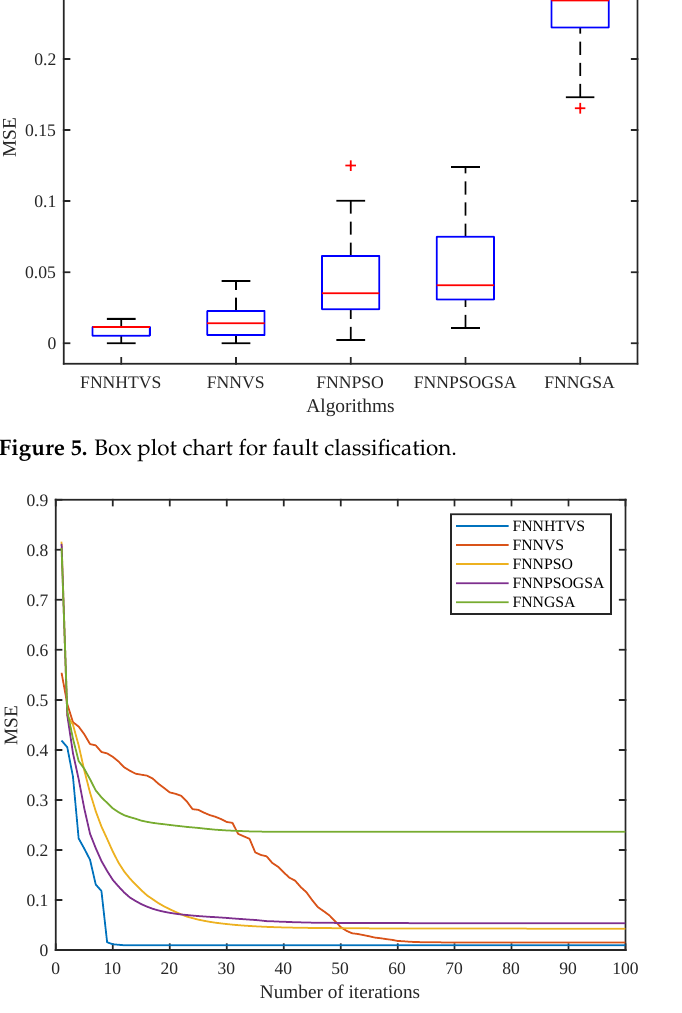
Figure 6. Convergence curve for fault